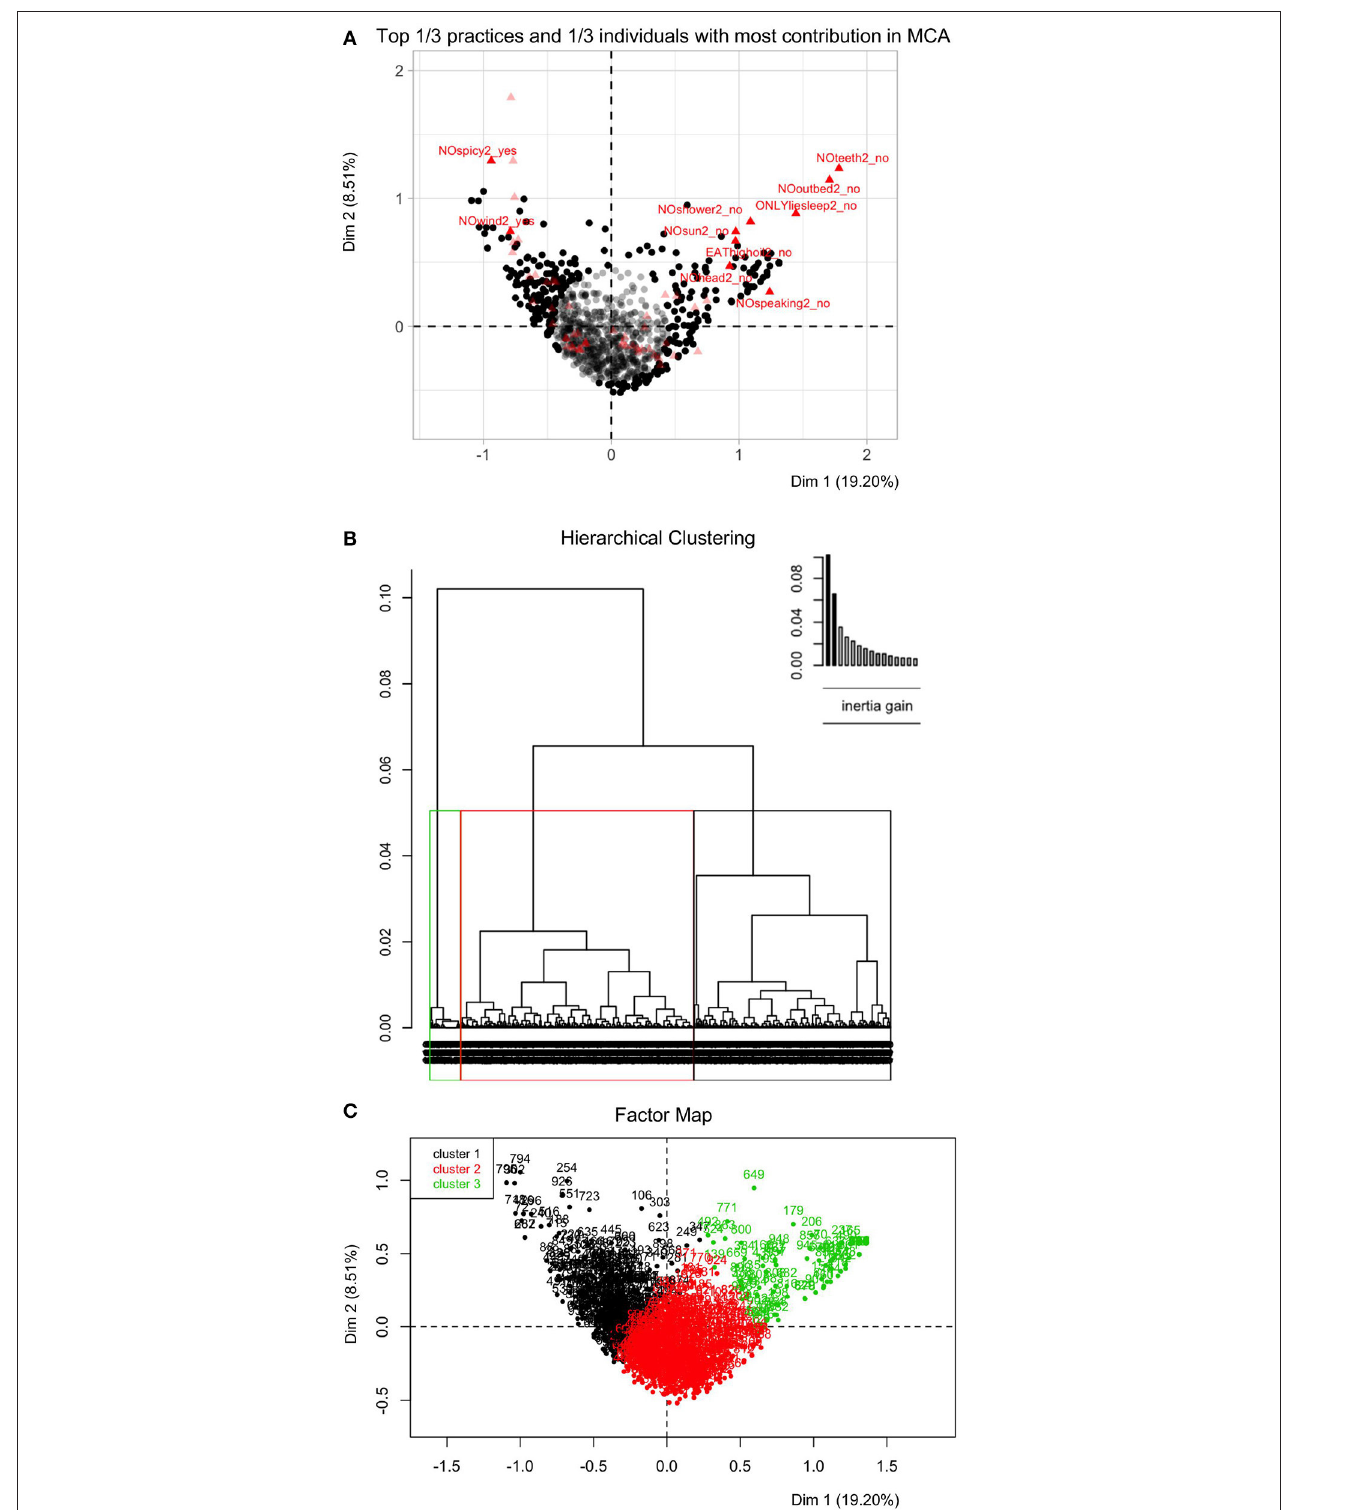
FIGURE 1 | Hierarchical clustering on principle components (HCPC) for postpartum practices among postpartum women in Hunan, China, 2018–2019 ( n = 955). (A) Top 1/3 practices and top 1/3 individuals with most contribution in multiple correspondence analysis (MCA). MCA retains information from the first converted 19 dimensions (principal components) in this study, which accounts for 80% of information of the original 30 postpartum practices. The first two dimensions in MCA accounts for 19.20 and 8.51%